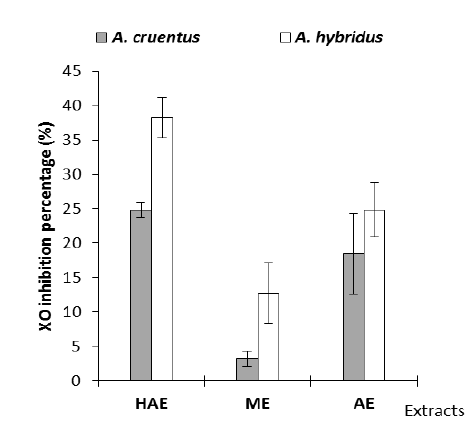
Figure 4. Extract xanthine oxidase (XO) inhibitory